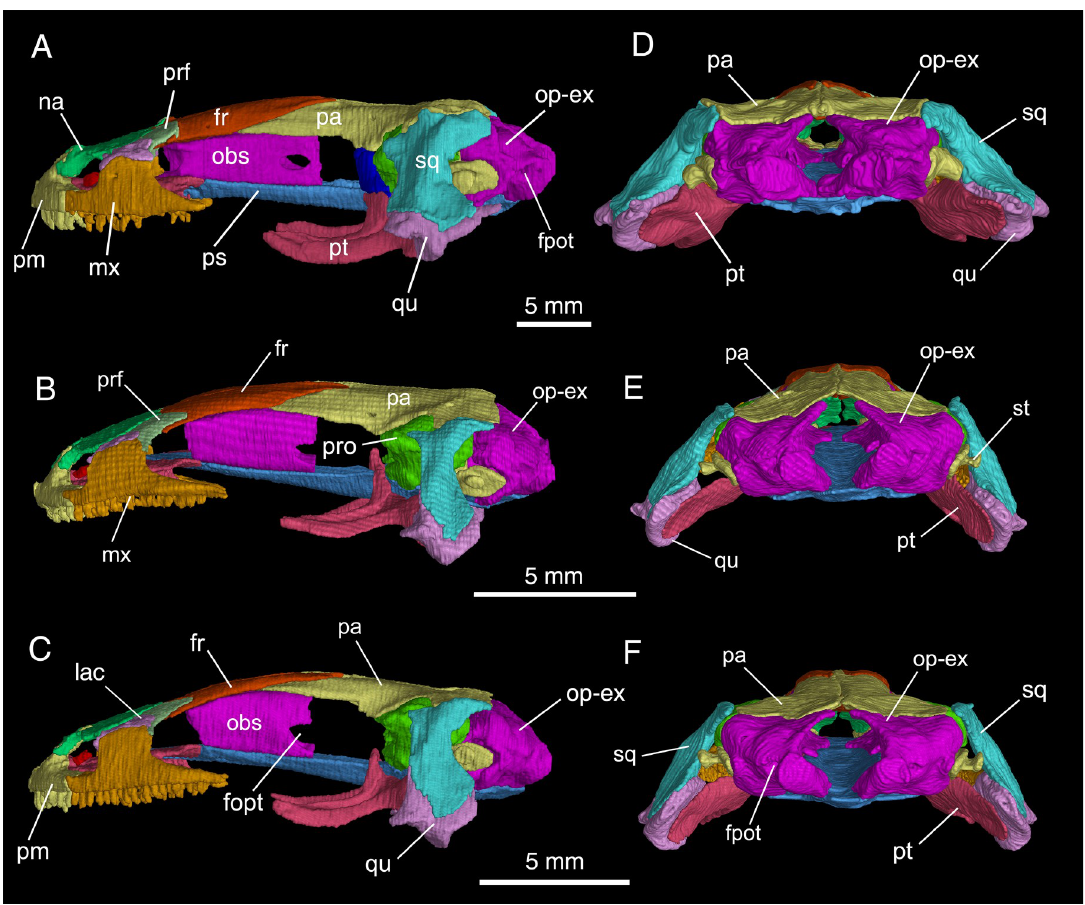
Fig 4. Micro-CT rendered reconstruction of the skull of Batrachuperus yenyuanensis in left lateral and occipital views. A, D, CIB 72599 from Tuowu, Mianning County; B, E, FMNH 49371, paratype specimen from Shuangertang, Yanyuan County; C, F, CIB 17308 from Shuangertang, Yanyuan